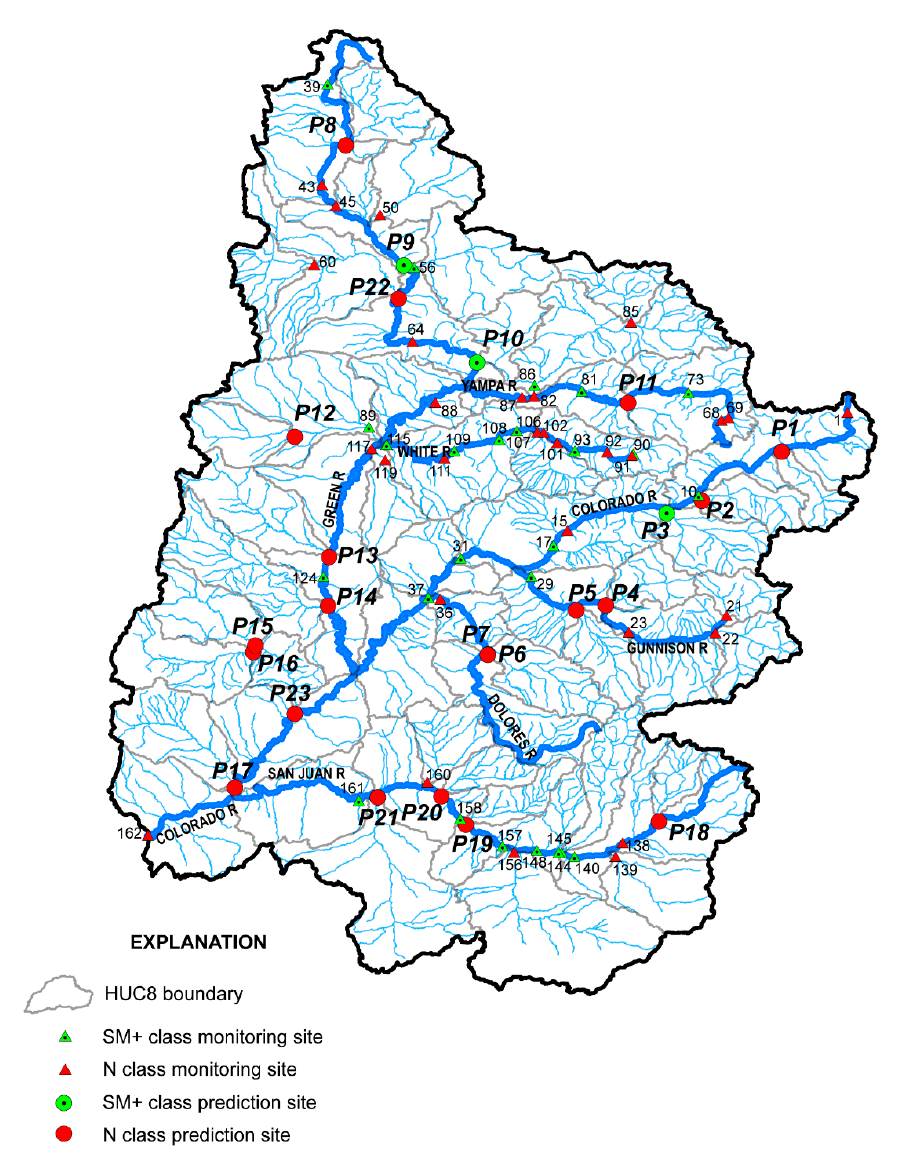
Figure 7. Map of sites with class based on monitoring data (triangles) or random forests model predictions (circles). Only monitoring sites along main stems of major rivers or at HUC8 pour points are presented here for visual clarity of map. See Figure 2, Tables S1 and S7 for all monitoring and prediction sites and results.